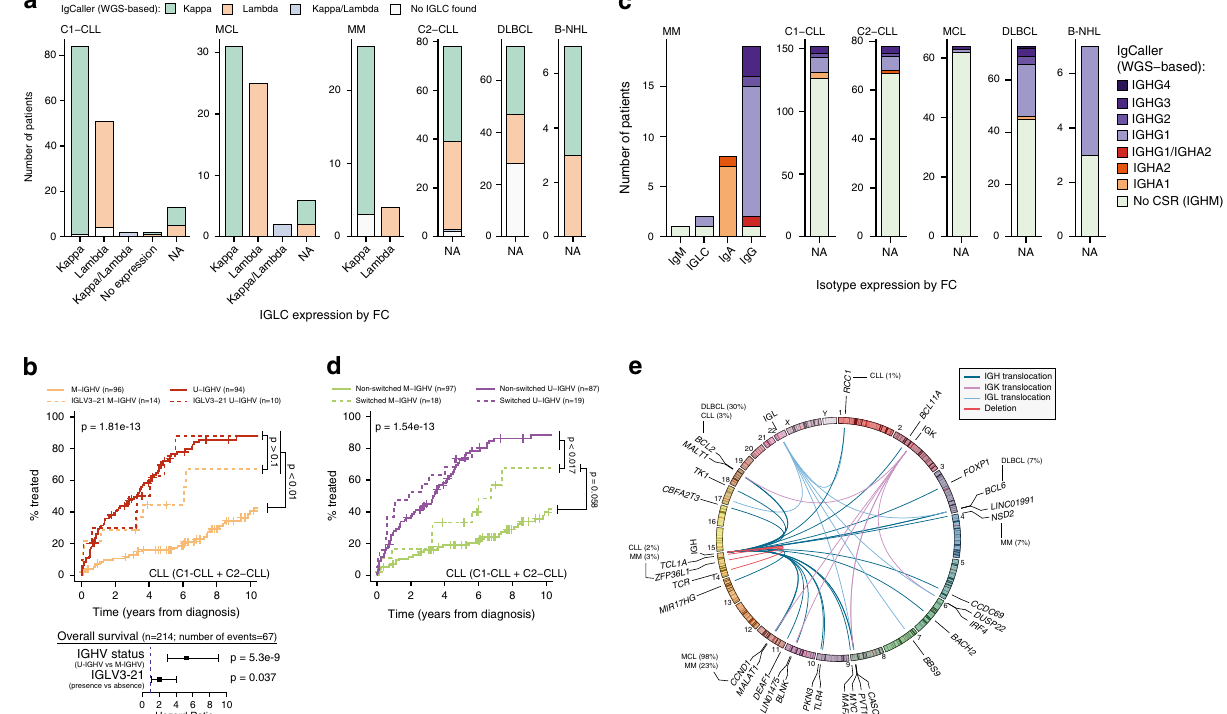
Fig. 3 Benchmarking of IgCaller: IGLC rearrangements, CSR, and oncogenic Ig translocations. a Agreement between the IGLC productive rearrangement detected by IgCaller and FC analysis. b TTFT and OS of patients with CLL according to the presence of IGLV3-21 rearrangements. P values for TTFT curves are from Gray test. P values for the multivariate analysis of OS are from Cox regression. c Comparison of the CSR identi fi ed by IgCaller and FC. d TTFT of CLL patients according to the presence of CSR. P values are from Gray test. e Circular representation of the oncogenic Ig rearrangements (translocations and deletions) identi fi ed by IgCaller genome-wide. Frequencies of recurrent alterations are shown. Source data are provided as a Source data fi